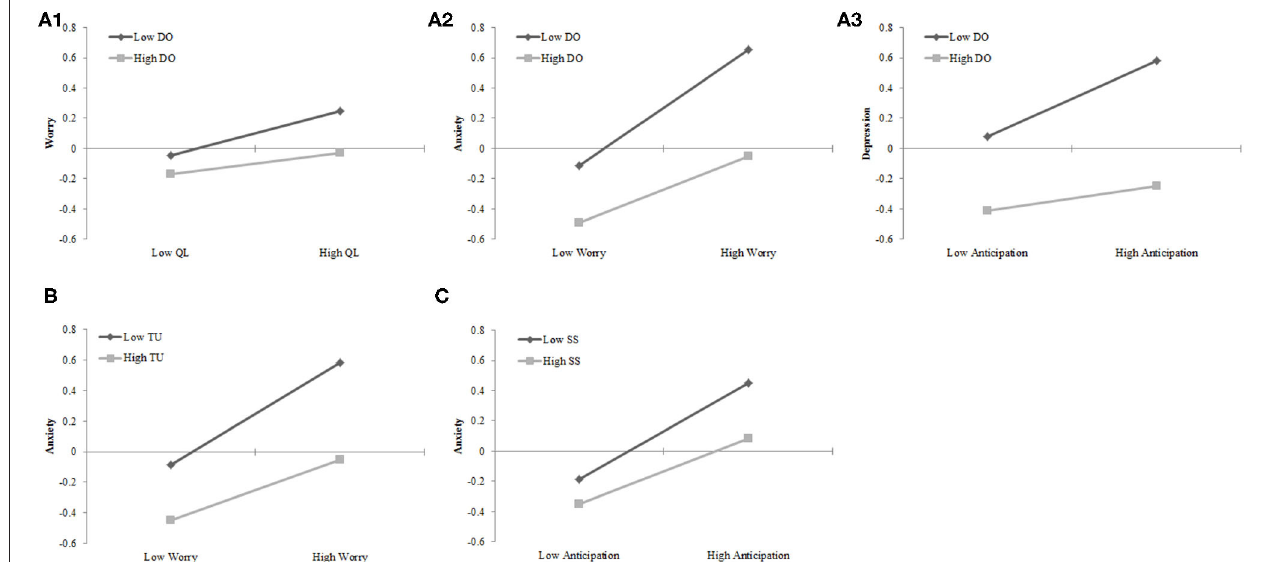
FIGURE 2 | The moderated role of dispositional optimism, tolerance of uncertainty, and social support. (A1) The moderated effect of dispositional optimism on the relationship between quarantine length and worry. (A2) The moderated effect of dispositional optimism on the relationship between worry and anxiety. (A3) The moderated effect of dispositional optimism on the relationship between anticipation and depression. (B) The moderated effect of tolerance of uncertainty on the relationship between worry and anxiety. (C) The moderated effect of social support on the relationship between anticipation and anxiety.